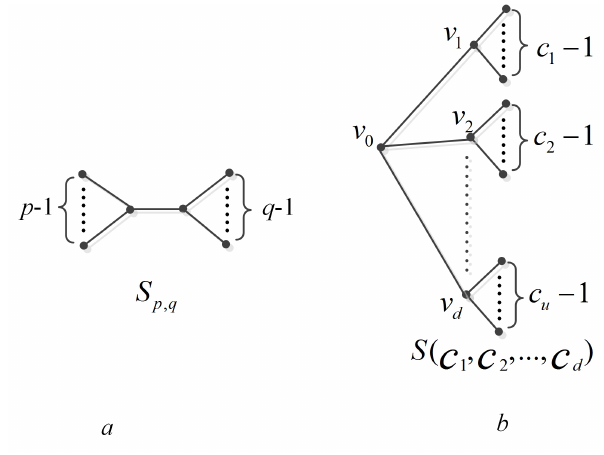
Fig. 1 Two classes of starlike